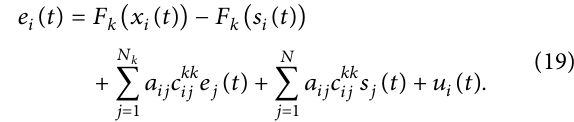
Figure 5: The multi-area power network topology